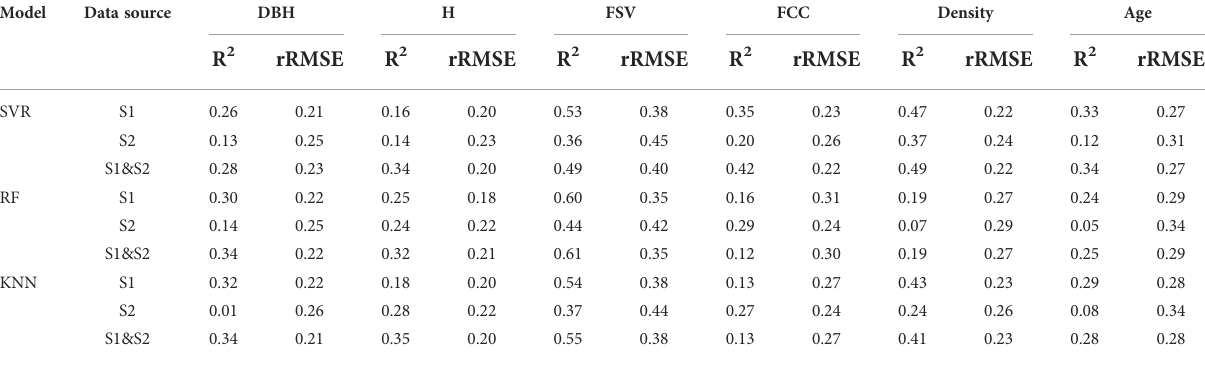
TABLE 8 The results of estimated forest parameters using different images